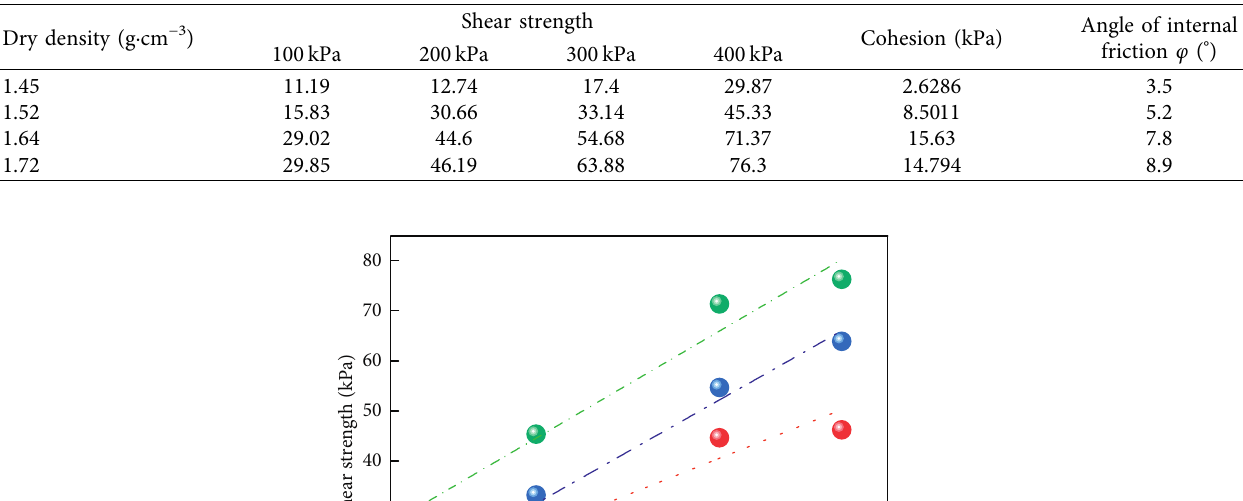
Table 3: Index values of shear strength and strength parameters at different dry densities.